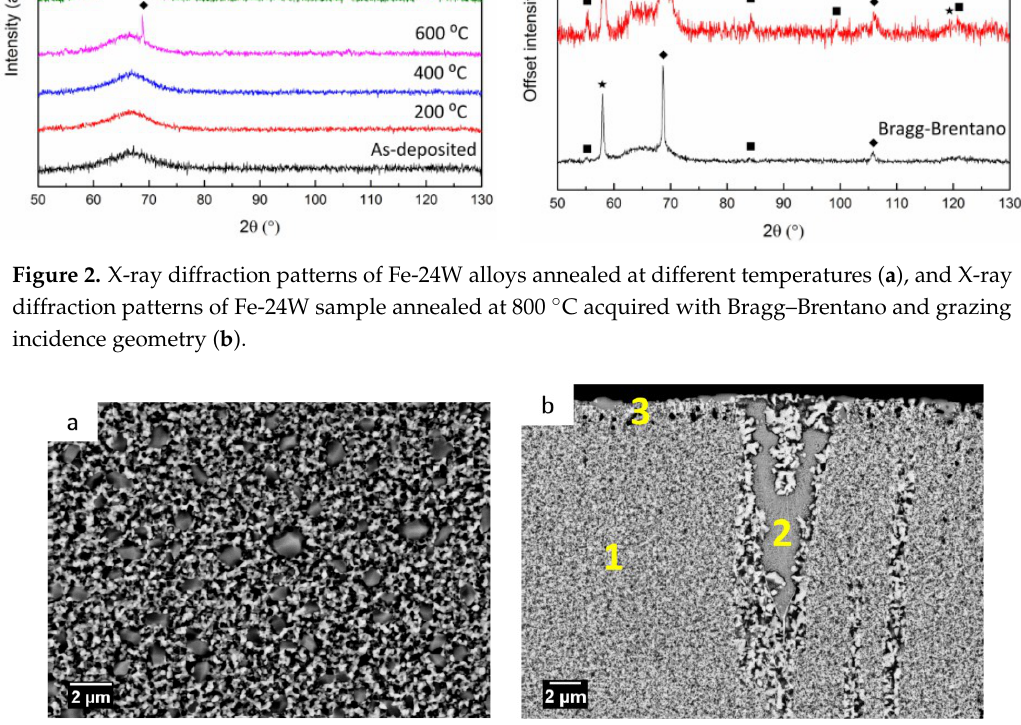
Figure 3. Back scattered electron image of the surface morphology (top view) ( a ), and of the cross-section ( b ) of the Fe-24W sample after one hour of annealing at 800 ◦ C. In ( b ) different areas along the cross-section are highlighted with the numbering 1, 2 and 3.